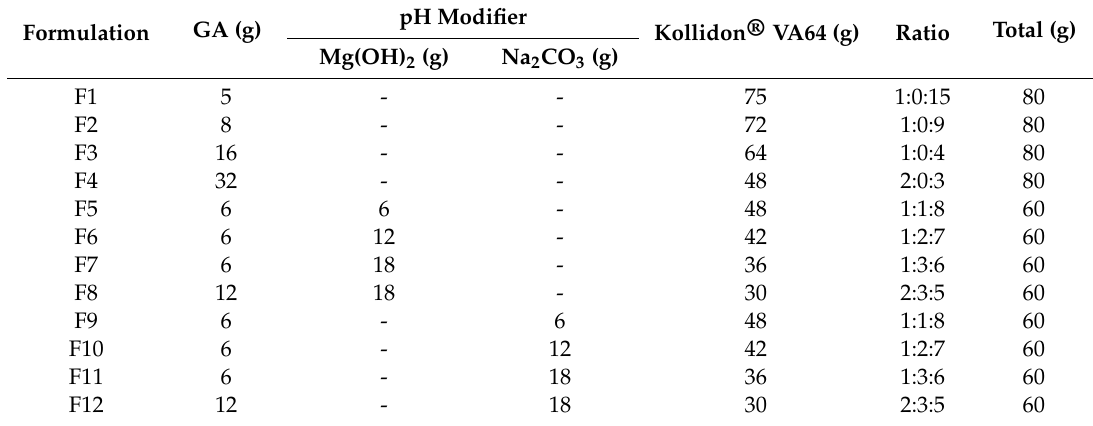
Table 1. Formulation compositions of solid dispersion (SD) powders (F1–F12). Formulation